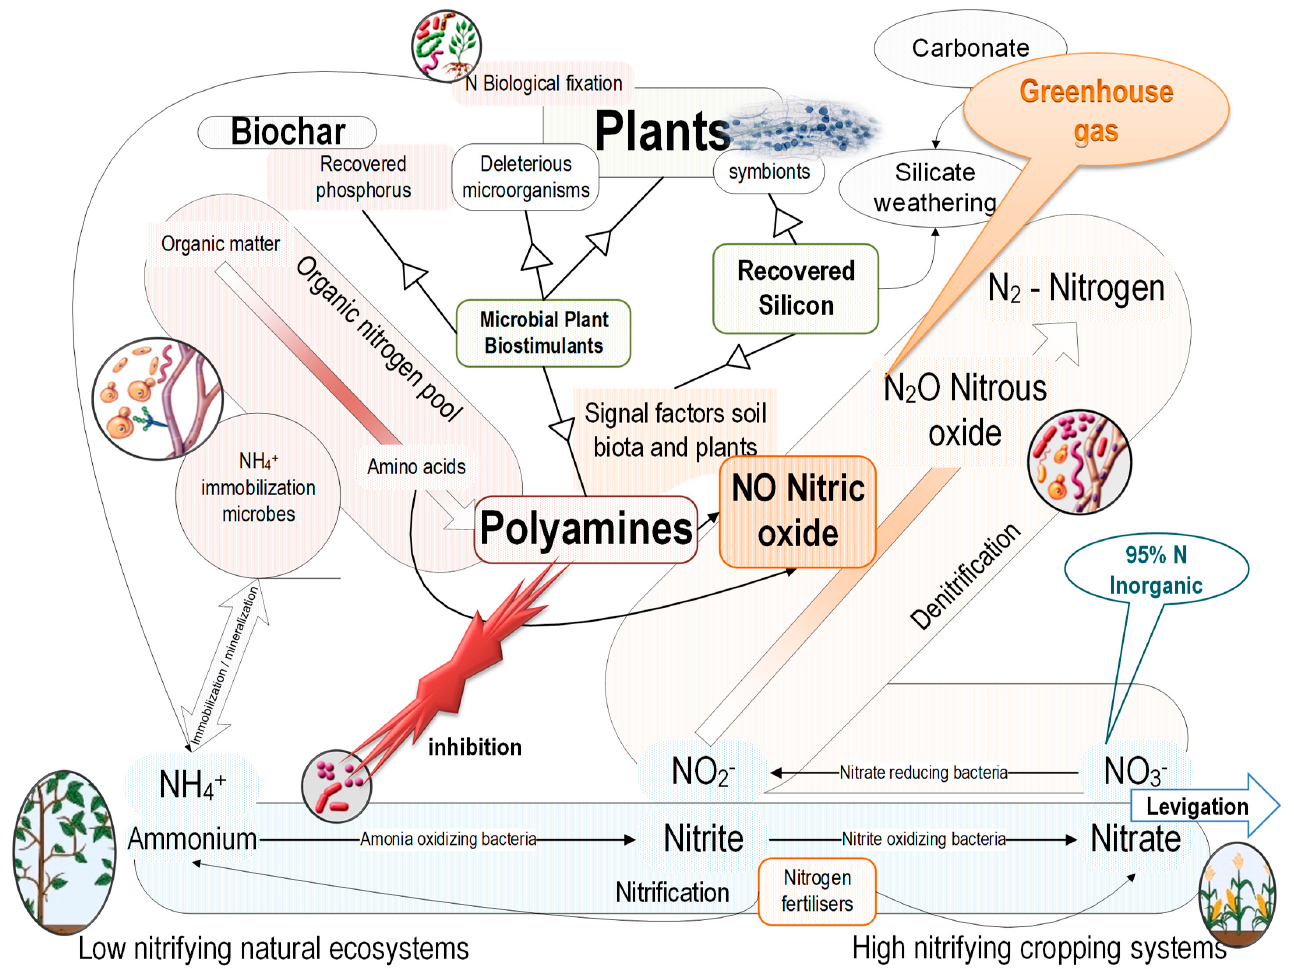
Figure 6. The contribution of the mineral nutrients recovered from biomass to carbon farming. Silicon recovered from biomass promote nutrient use efficiency and modulate soil microbiota, including the microorganisms acting for silicate weathering. Recovered microbial strain used for the production of the enzymes acting on biomass could be used to produce microbial plant biostimulants. Biochar promotes the sustainable use of recovered phosphorus.